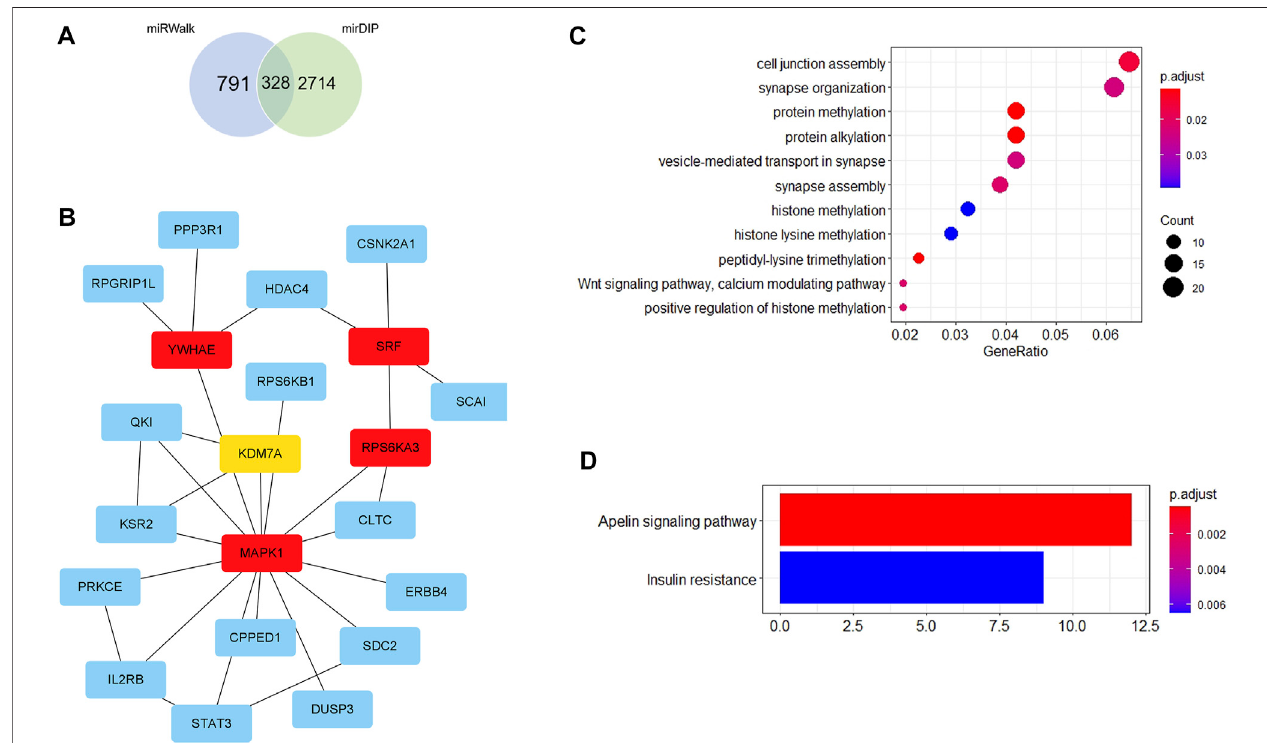
FIGURE5| Bioinformaticsanalysis. (A) Venndiagramshowstheoverlappedtargetgenesof9signi fi cantdysregulated miRNAspredicted bymiRWalkandmirDIP. (B) Five hub genes with themost substantial interactions according to the calculated results by eccentricity method. The darker the color ofnodes, the higher the score. (C) Bubble chart of 11 GO terms. (D) Bar chart of 2 KEGG